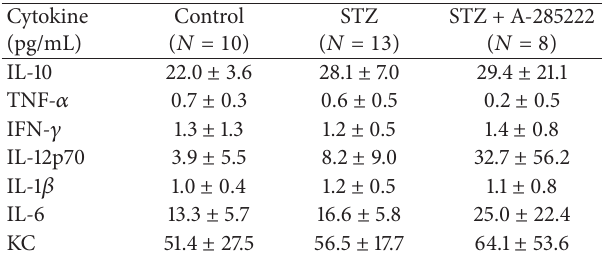
Table 1: A-285222 treatment does not affect plasma cytokine levels in diabetic NFAT-luc